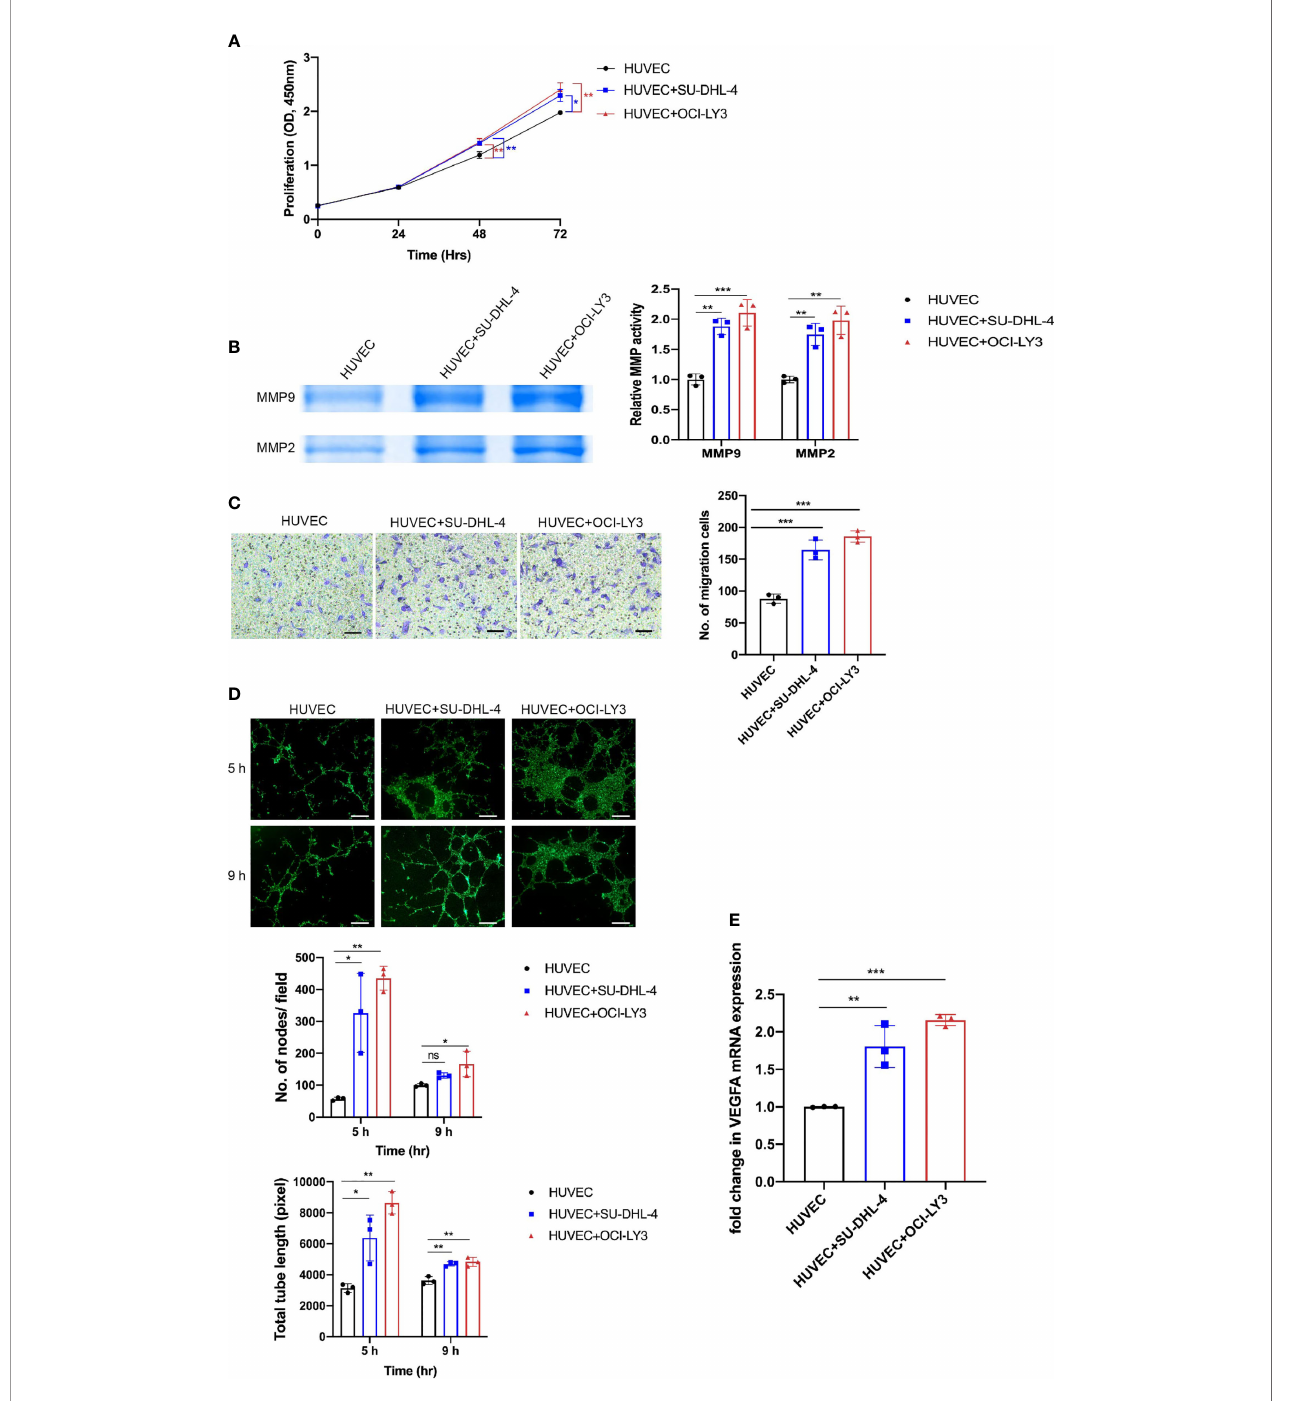
FIGURE 3 | GCB and ABC DLBCL cells promoted proliferation, MMP2/9 activity, migration, and tube formation of endothelial cells. (A) Proliferation of endothelial cells was assessed by CCK-8 assay at indicated time points (24, 48, and 72 h). (B) Activity levels of MMP2/9 were evaluated by gelatin zymography. Representative images and quantitative analysis of MMP2/9 activity are shown. (C) Cell migration of HUVECs was detected by a transwell migration assay. Representative images and quantitative analysis of migratory cells are shown. Scale bar, 200 m m. (D) HUVECs seeded on Matrigel were co-cultured with or without DLBCL cells. Representative images of tube formation assay at 5 and 9 h were shown. Number of nodes per fi eld and total tube length were quanti fi ed using ImageJ. Scale bar, 1 mm. (E) VEGF mRNA expression in HUVECs was analyzed by qRT-PCR. Error bars, SD; n = 3 independent experiments; * p < 0.05, ** p < 0.01, *** p < 0.001. ns, not signi fi cant; GCB, germinal center B cell; ABC, activated B cell; DLBCL, diffuse large B-cell lymphoma; CCK-8, Cell Counting Kit-8; HUVEC, human umbilical vein endothelial